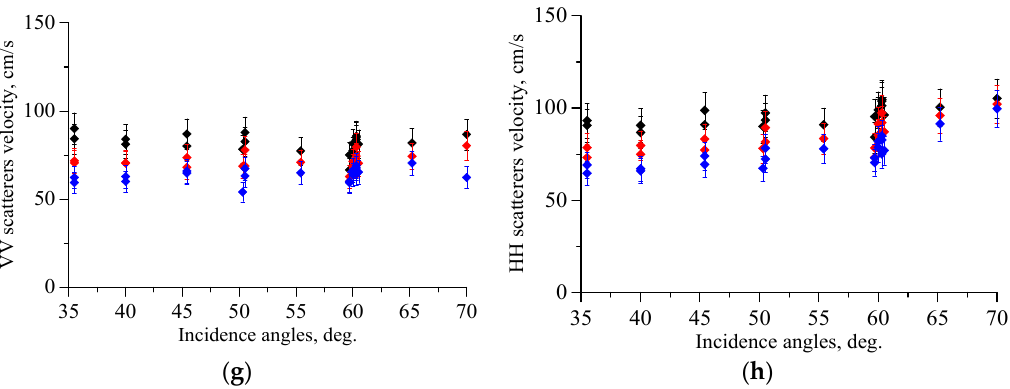
70 Incidence angles, deg. ( h ) Figure 3. Case study 4.2. ( a ) The velocity and ( b ) direction of ADCP current at depths of 1 m (black curve), 4 m (red curve), and 10 m (blue curve). ( c ) The wind speed and ( d ) direction. The scatterer’s velocity for the radar return at VV ( e ) 0–150 min, ( g ) 150–300 min) and HH ( f ) 0–150 min, ( h ) 150– 300 min) polarizations. Black dots are S-band, red—C-band, blue—X-band.